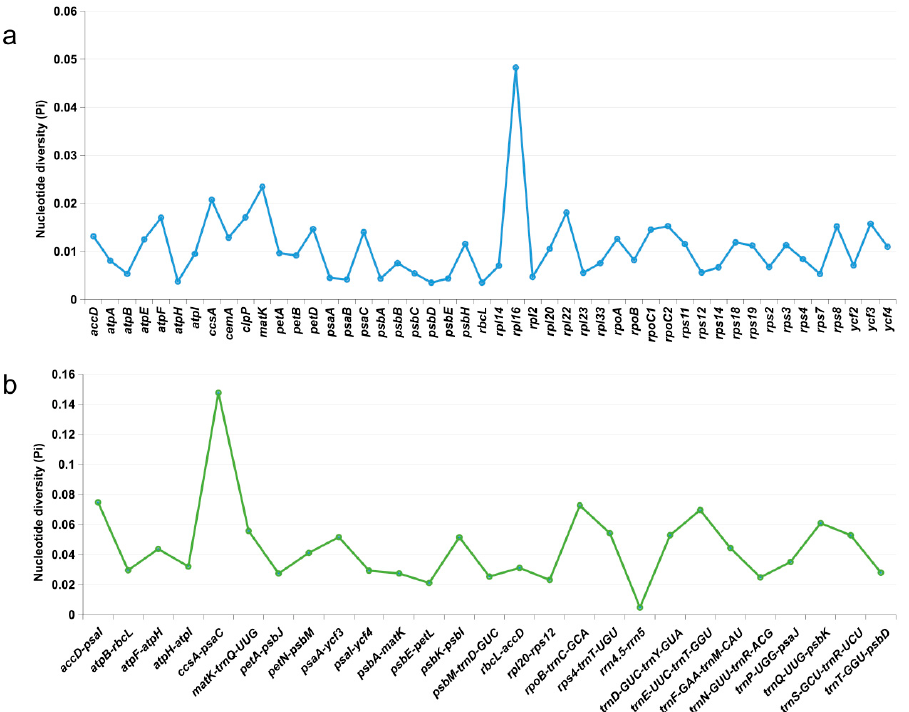
Figure 5. Nucleotide diversity of shared various regions with Pi > 0 and length > 200 bp in 15 chloroplast genomes of Taxillus species. ( a ) Pi values in the genes regions. ( b ) Pi values in the intergenic spacers regions.